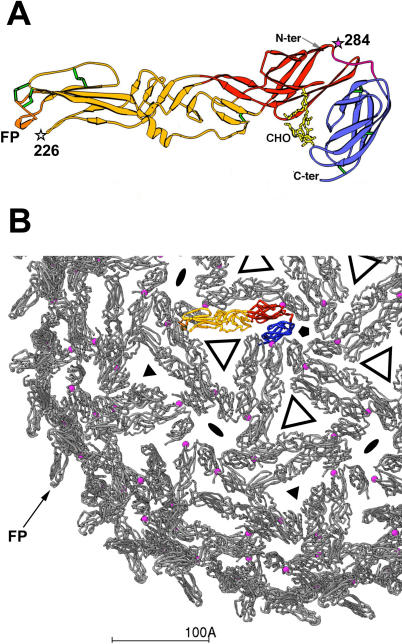
Localization of the E1 Changes on the 3D Structure Modelled from the Crystal Structure of SFV E1(A) Ribbon diagram of E1, with domain I coloured red, domain II yellow, and domain III blue. Green tubes mark the disulfide bonds. The fusion peptide, at the tip of the molecule (in domain II) is coloured orange and labelled. The N-terminus and the C-terminus observed in the crystal (which is 30 aa upstream of the trans-membrane region) are also labelled. The two unique changes observed in the Indian Ocean isolates are indicated by stars and labelled: positions 226 (white) and 284 (magenta).(B) Partial representation (one octant, slightly extended) of the icosahedral E1 scaffold at the surface of the virion, viewed down a 5-fold symmetry axis. One E1 protomer is highlighted in colours, as in (A); all the others are represented in grey. The location of the some of the icosahedral symmetry axes are drawn as solid black symbols: pentagon for 5-fold axis, triangle for 3-fold axes, ellipse for 2-fold axes (which in the T = 4 lattice of alphaviruses are coincident with quasi 6-fold axes). Open triangles indicate roughly the location of the E2 trimers that interact tightly with E1, covering domain II and the fusion peptide, and presenting the main antigenic sites. The open triangles mark also quasi 3-fold symmetry axes of the T = 4 surface icosahedral lattice. A magenta ball marks the location of Glu 284, at an inter-E1 protomer contact site. This contact is propagated 240 times at the surface lattice (note all pink balls drawn on the grey protomers). Note that the fusion peptide, in orange, is pointing up and away from contacts with other E1 protomers. This is more easily seen at the periphery of the virion, where one of them is labelled (FP). In the virion, this region of E1 is not accessible, covered underneath the E2 molecule [
20].